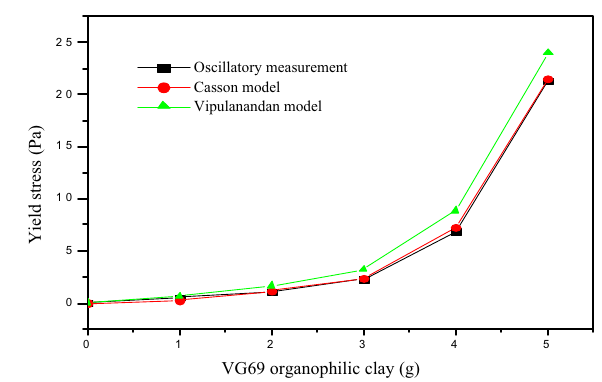
Fig. 7 Variation of critical shear stress as a function of VG69 organo- philic clay quantity Fig. 8 Comparison of the yield stress obtained by the Casson model and the Vipulanandan model with the oscillatory measurement